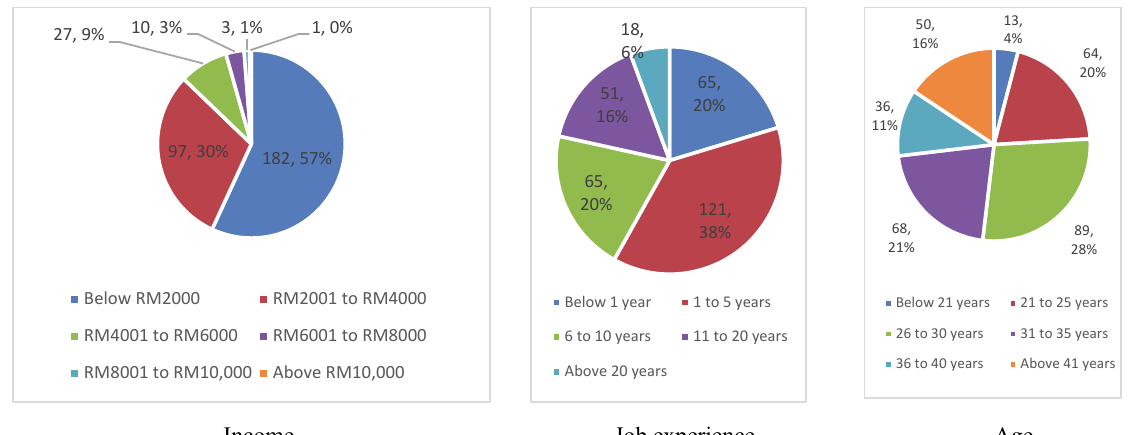
Fig. 2. Personal characteristics of the participants